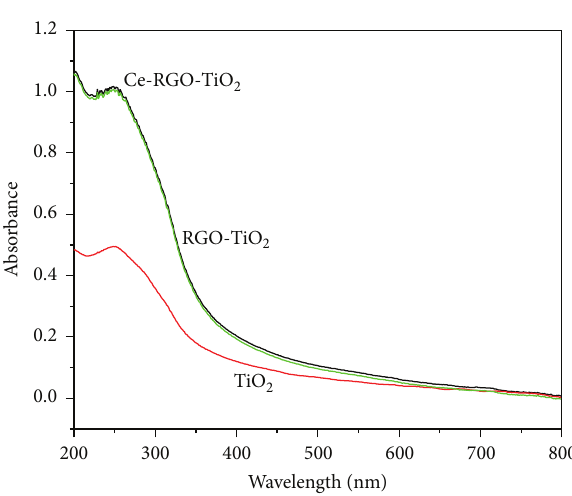
Figure 6: Effect of Ce loading on UV absorbance in RGO-TiO 2 photocatalysts.